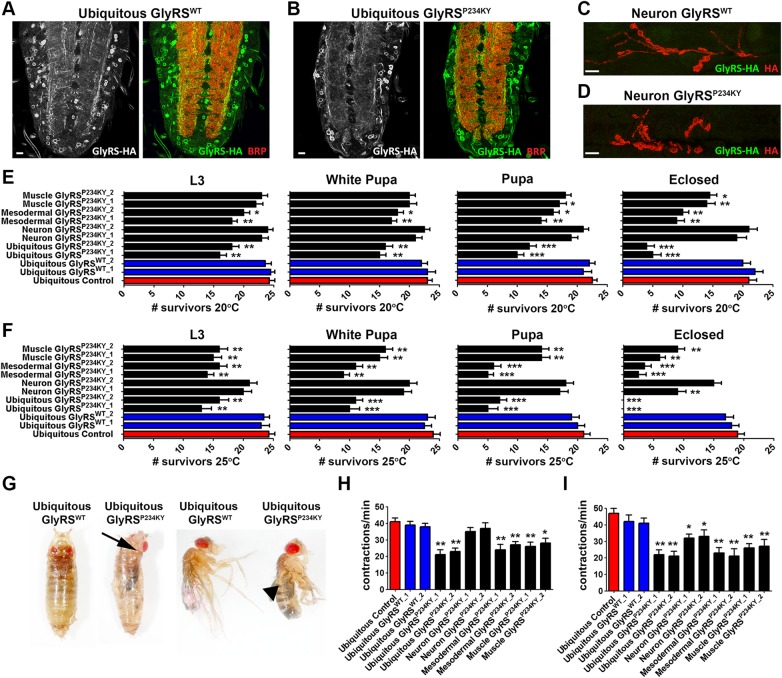
Dominant, toxic effects caused by GlyRSP234KY lead to non-cell autonomous longevity and motor defects. (A) GlyRSWT and (B) GlyRSP234KY localization in the central nervous system of larvae ubiquitously (1032-GAL4) expressing UAS-garsWT_2 and UAS-garsP234KY_2, respectively. (C) GlyRSWT and (D) GlyRSP234KY localization at the NMJ in larvae neuronally expressing UAS-garsWT_2 and UAS-garsP234KY_2, respectively. Note that GlyRS expressed in neurons does not reach the peripheral synapse. (E and F) GlyRSP234KY toxicity was analysed by expressing garsP234KY ubiquitously (1032-GAL4), in mesoderm (how-GAL4), muscle (MHC-GAL4) or neurons (elav-GAL4) at 20°C (E) and 25°C (F). Transgene expression is lower at 20 than 25°C. Flies ubiquitously expressing garsWT (blue bars) and CD8::GFP (red bars) were used as controls. (G) Mutant garsP234KY flies reach the pupal stage, but fail to eclose and often become trapped in their pupal cases (arrow). The few flies that escape and reach adulthood display wing expansion defects (arrow head). (H) Ubiquitous, mesodermal and muscle expression of garsP234KY caused a significant loss of muscle contractions at 20°C. (I) Ubiquitous, mesodermal, muscle and neuronal driven garsP234KY expression also reduced larval muscle contractions at 25°C. For all graphs, *P < 0.05; **P < 0.01; ***P < 0.001 Dunn's multiple comparison test. For survival studies, 25 flies per genotype were scored over four independent experiments. For muscle contraction studies, at least 15 larvae were analysed per genotype. Scale bars = 10 μm.